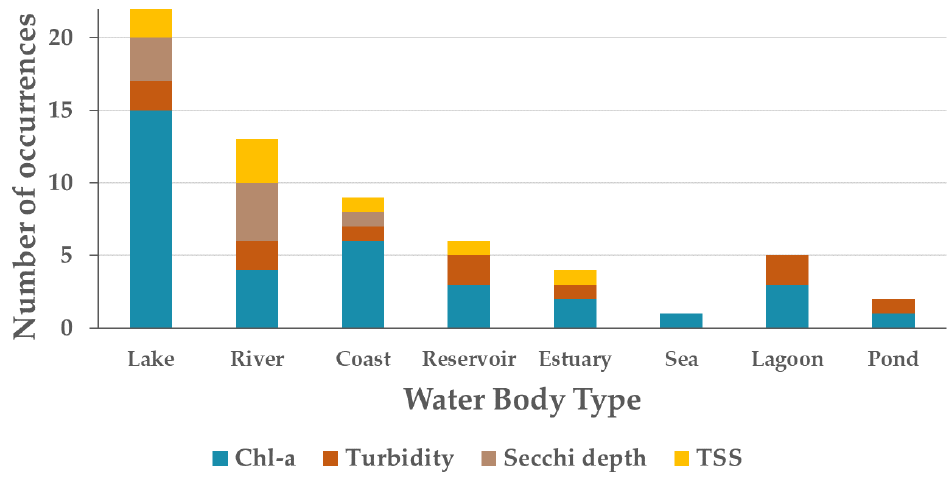
Figure 7. The distribution of the four predominant indicators per water body type .